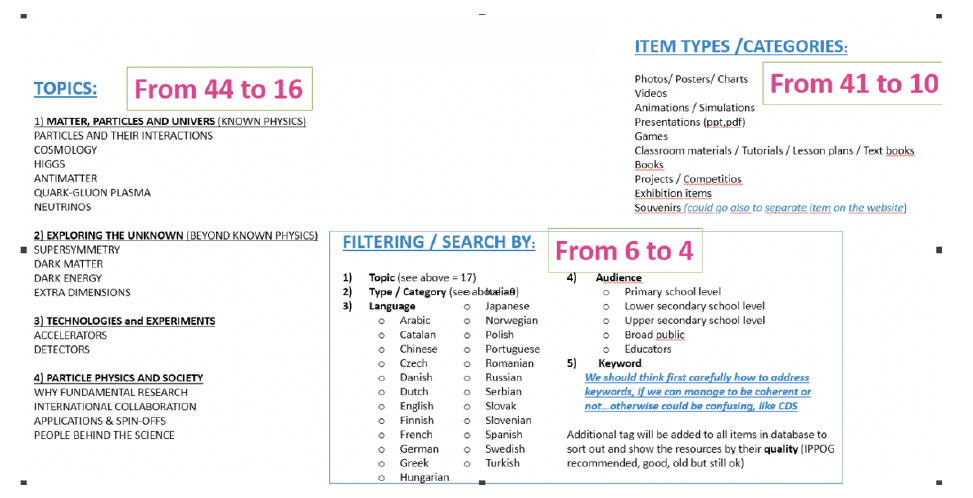
Figure 1. New IPPOG Resource Database categories